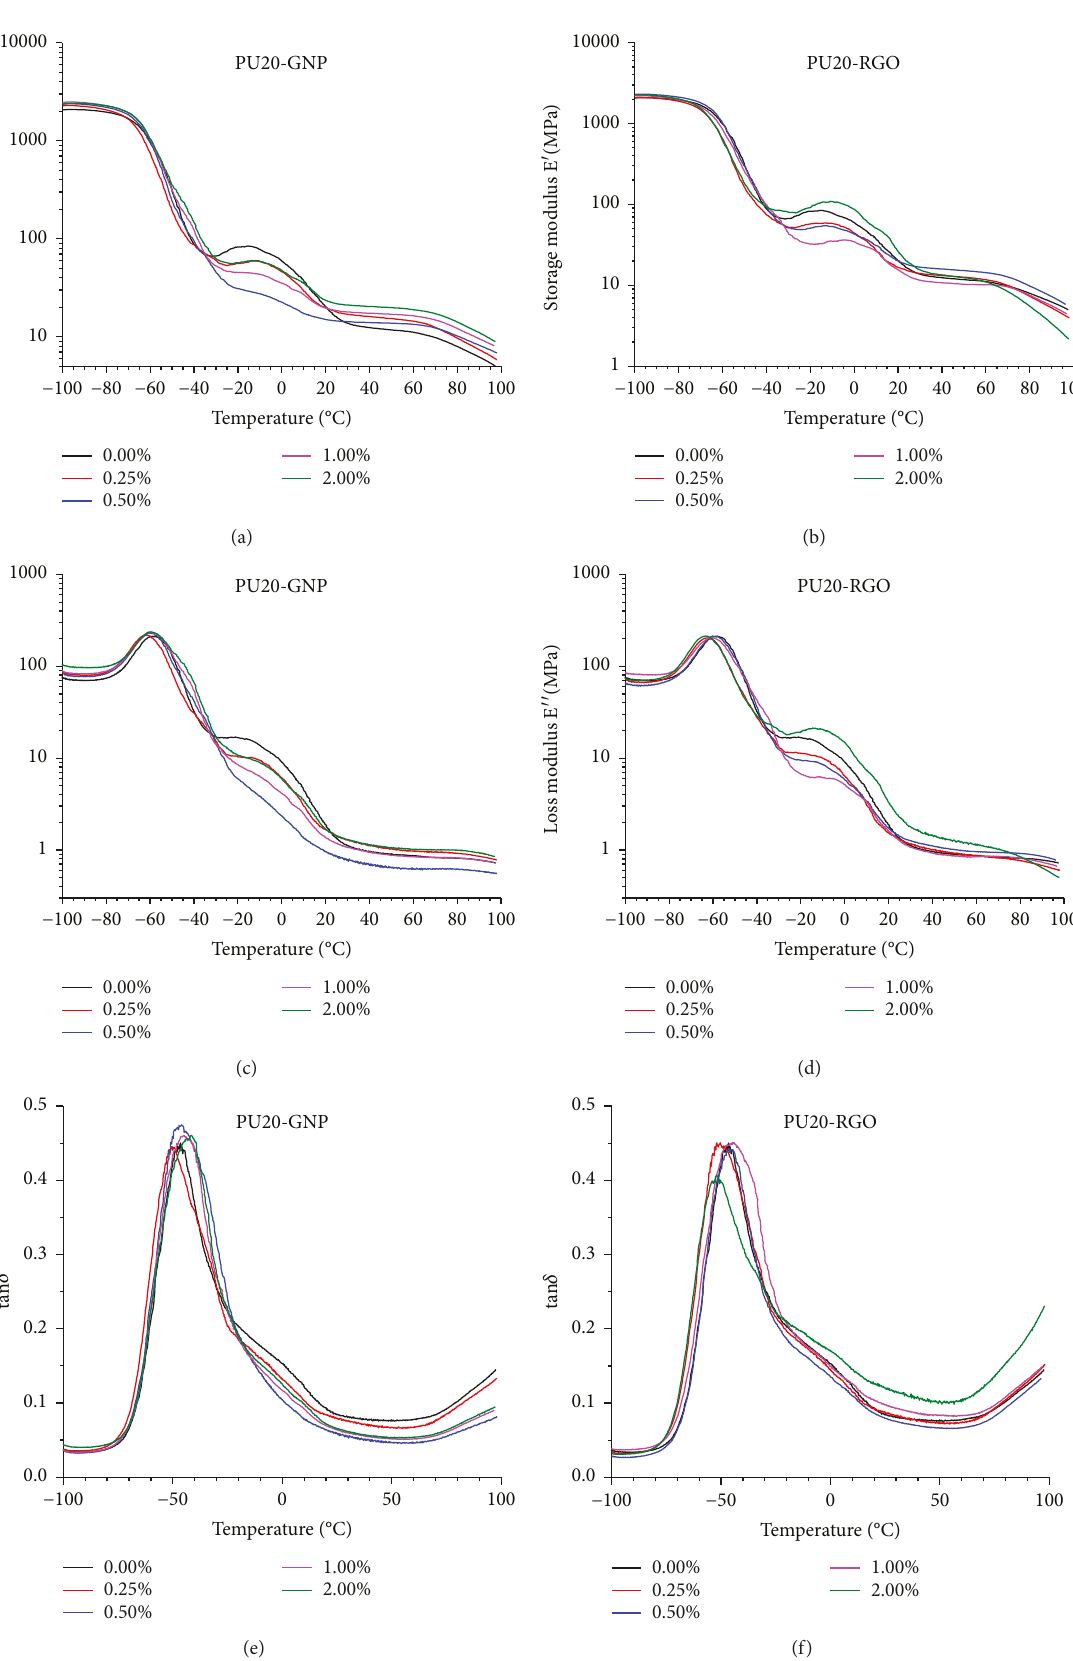
Figure 14: Thermomechanical behavior of PU nanocomposites PU20-GNP and